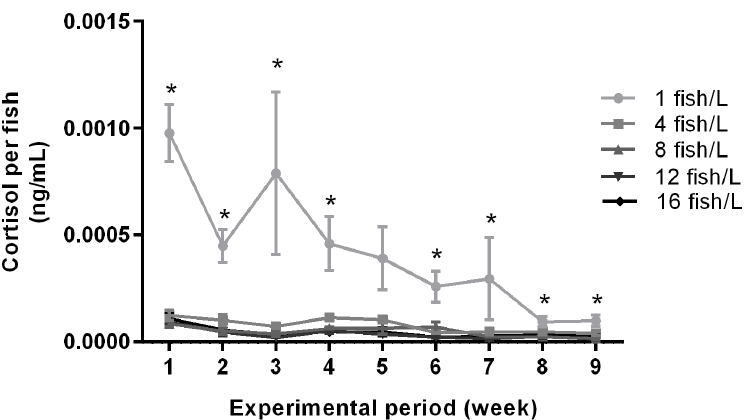
Figure 5. Water cortisol concentrations throughout the exposure period in tanks holding zebrafish at densities of 1 ( n = 5), 4 ( n = 3), 8 ( n = 3), 12 ( n = 3), or 16 ( n = 3) fish/L, respectively. The graph shows cortisol levels per fish in each tank. Data are shown as mean ± standard error of the mean (SEM). Statistical significance between groups is presented as * p < 0.05.